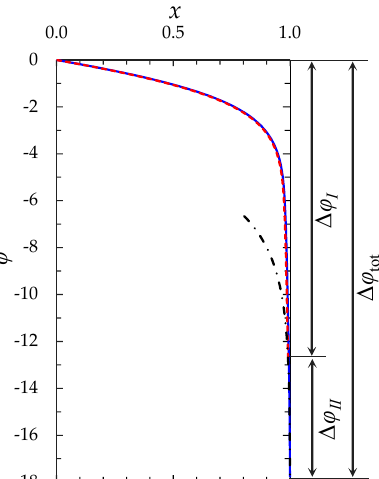
Figure 6. Distribution of the electric potential for i/i lim = 2 at time t = 0.213, ε = 3 × 10 − 7 . The solid line is calculated numerically using the “primary” model (the region of applicability is 0 ≤ x ≤ 1), the dashed line is calculated using the “zonal” model (the region of applicability is 0 ≤ x ≤ 1 − δ 3 ), the dash-dotted line is the result of calculation of by Formula (24) (the region of applicability is 1 − δ 3 ≤ x ≤ 1). As shown in Appendix D, the use of “zonal” model allows reducing the number of mesh elements 75 times and the total calculation time, 35 times, in comparison with the “primary” model, when calculating chronopotentiograms for the case of ε = 3 × 10 − 7 , i/i lim = 2.